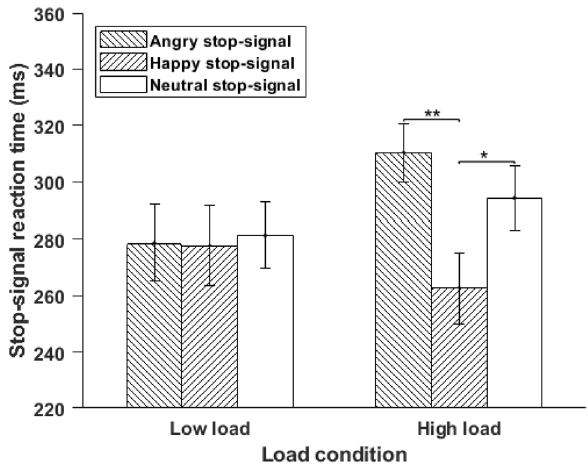
Figure 4. Mean SSRT was plotted as a function of load and emotion for Experiment 2. Vertical lines represent ± 1 within-subject standard error. SSRT: Stop-Signal Reaction Time; * p < 0.05, ** p <